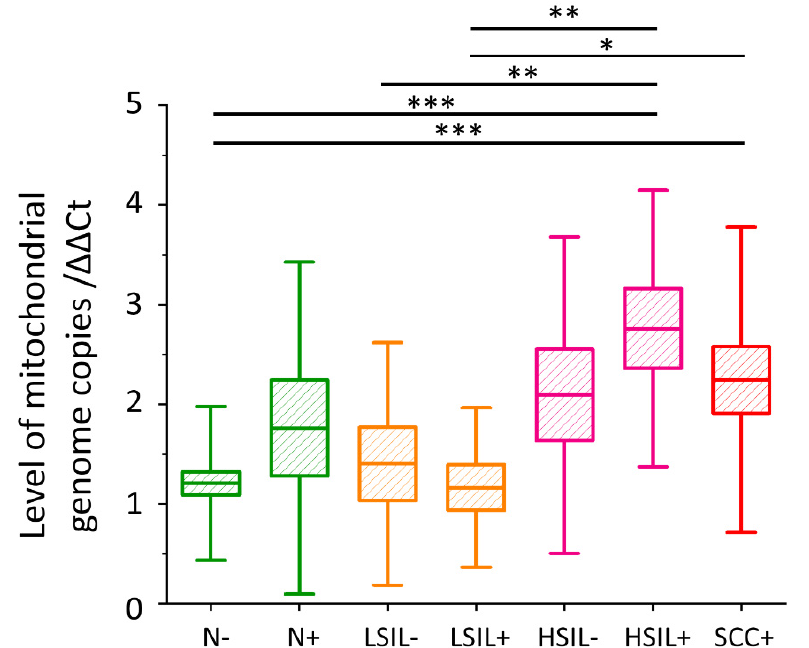
Figure 5. The level of mitochondrial DNA copies in cervical epithelial cells. The comparison of the level of mtDNA copies in cervical epithelial cells in studied groups obtained by calculating a Ct value from the Ct value of the ND1 gene relative to the Ct value of the beta-actin gene. Mean values ± SEM are given as box plots: mean (horizontal line), SEM